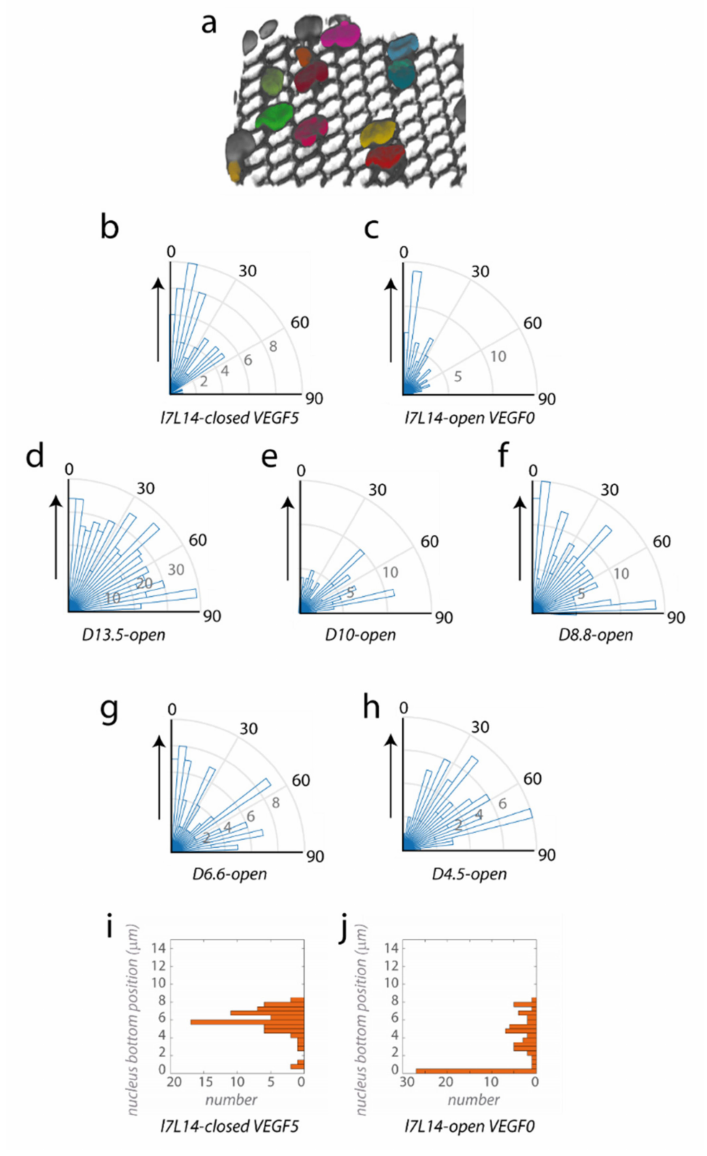
Figure A1. Additional data for nuclei quantification. ( a ) Example of nuclei segmentation on top of a l7L14 microstructure. ( b – h ) Histograms of nuclei orientations in different geometries, in the top layer above the microstructures: ( b ) l7L14-closed with 5 ng/mL VEGF (68 nuclei in 3 structures), ( c ) l7L14-open without VEGF (1 structure), ( d ) D13.5-open structures (607 nuclei in 6 structures), ( e ) D10-open structures (95 nuclei in 1 structure), ( f ) D8.8-open structures (178 nuclei in 4 structures), ( g ) D6.6-open structures (94 nuclei in 5 structures), ( h ) D4.5-open structures (77 nuclei in 7 structures). ( i , j ) Vertical engagements: position of the bottom of the nuclei for: ( i ) l7L14-closed with 5 ng/mL VEGF, ( j ) l7L14-open without